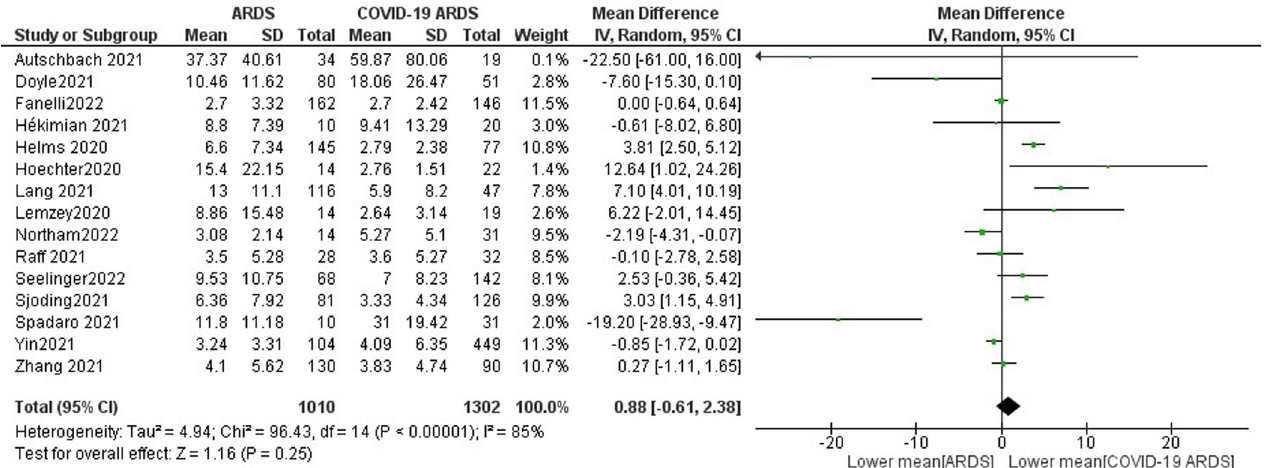
Fig 3. Forest plot of D-dimer level. A comparison of mean D-dimer levels between non-COVID-19 patients [ARDS] and COVID-19 patients [COVID-19 ARDS]. There was no statistically significant difference between the mean D-dimer levels in the two groups (p = 0.25).